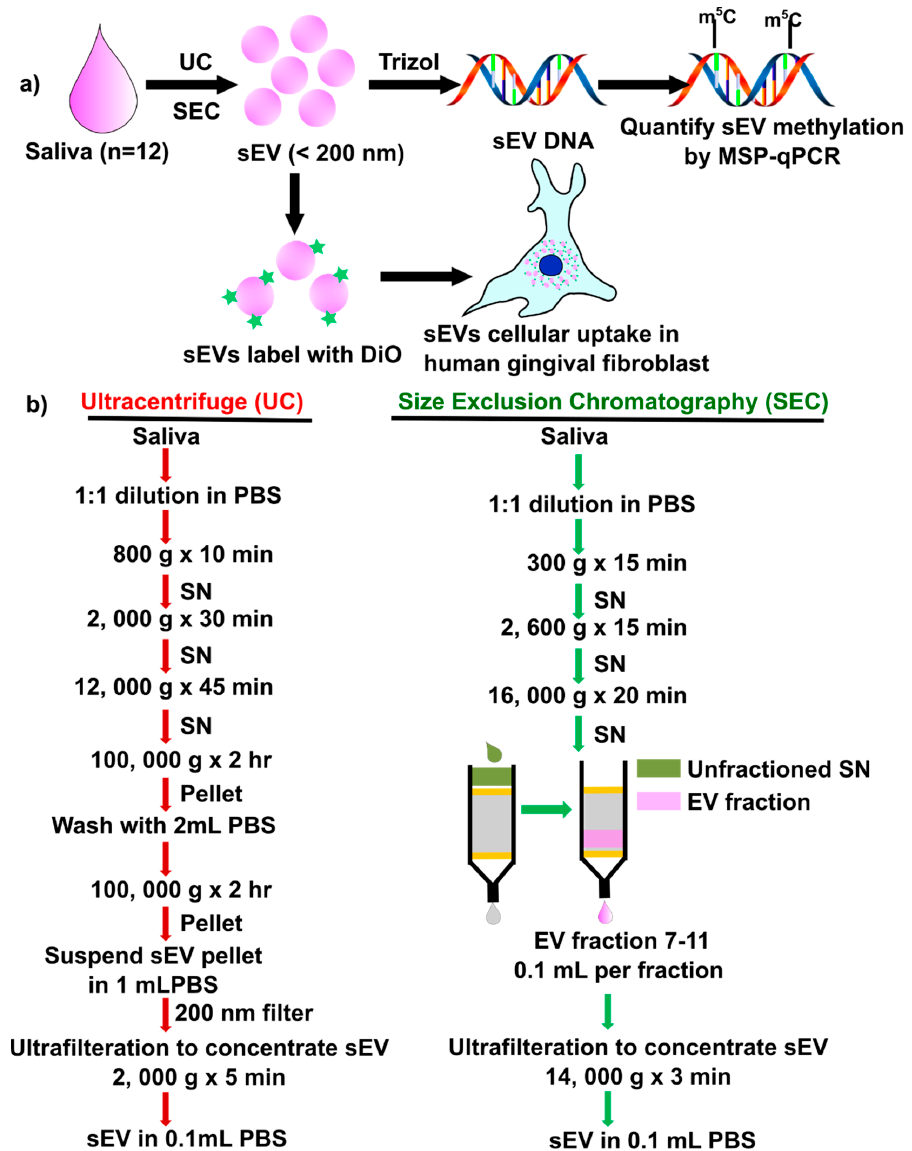
Figure 1. Schematic diagram of the study design ( a ) and detailed methods ( b ) to isolate salivary small extracellular vesicles (sEV) by ultracentrifuge (UC) and size exclusion chromatography (SEC). DiO: 3,3 ′ -Dioctadecyloxacarbocyanine perchlorate; qMSP: quantitative methylation-specific real-time PCR; SN: supernatant.